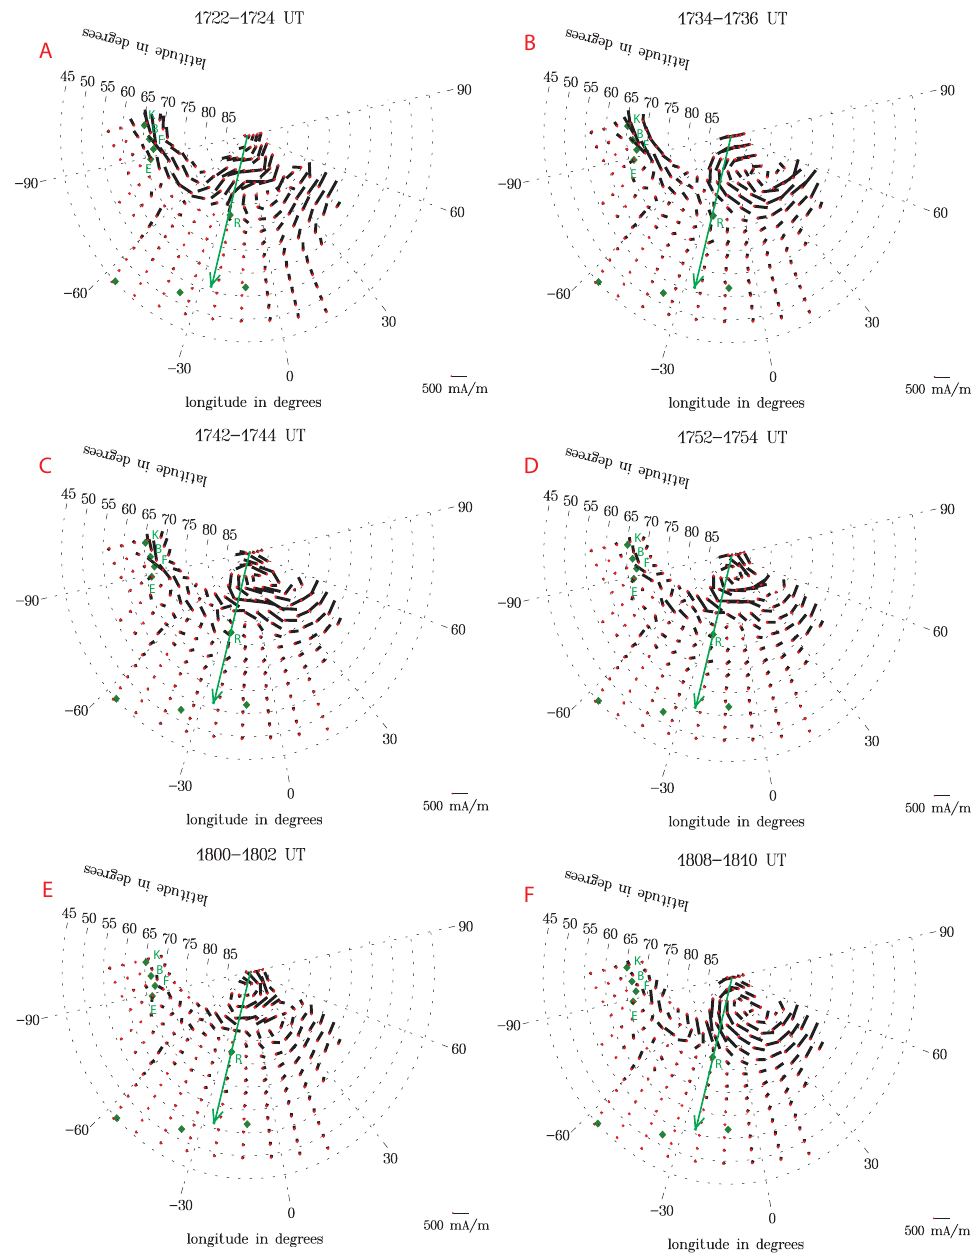
Fig. 11. The averaged equivalent currents for six 2-min intervals. (A) 17:22–17:24UT; (B) 17:34–17:36UT; (C) 17:42–17:44UT, (D) 17:52– 17:54UT; (E) 18:00–18:02UT and (F) 18:08–18:10UT. The green dots show the locations of the high/low latitude ground stations from Fig. 8, and RANK is labeled with a green “R”. The direction of the Sun is indicated by the large green arrow in each panel.